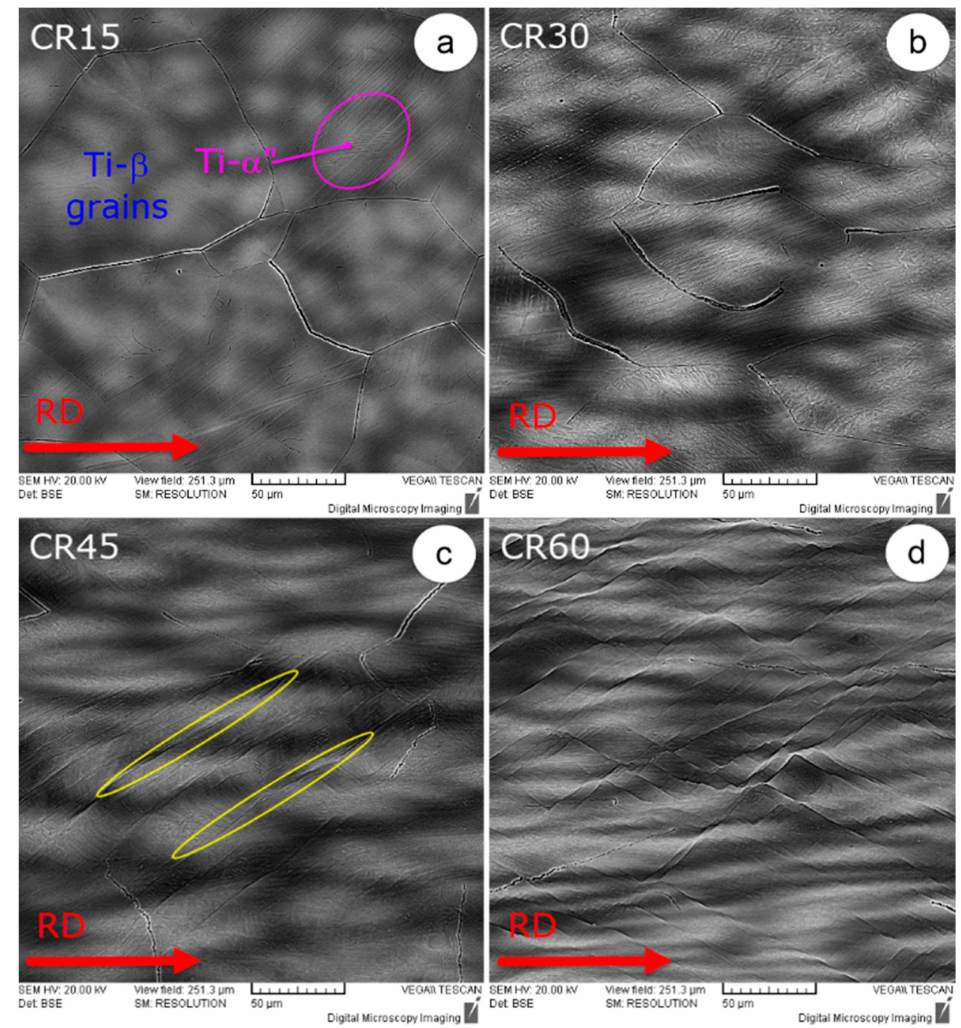
Figure 3. Microstructure evolution during cold deformation processing: 15% cold-rolled (CR15) ( a );